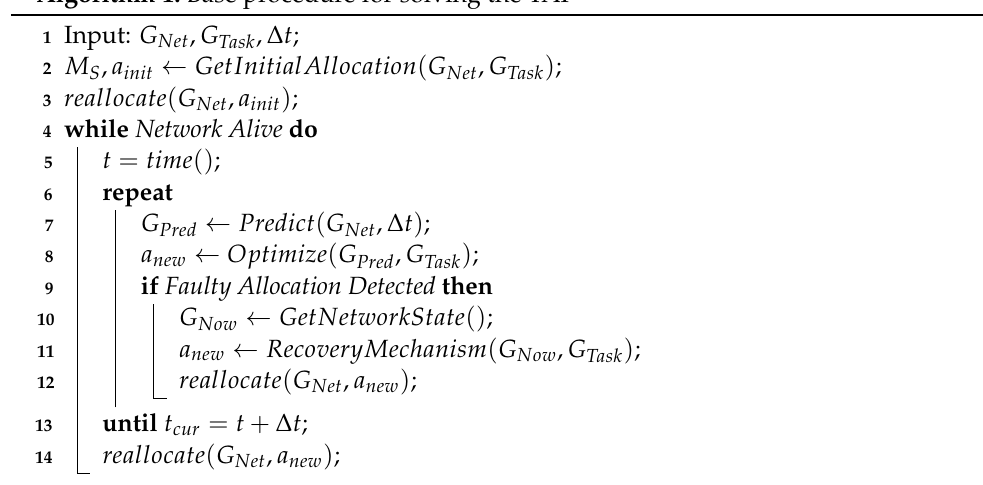
Algorithm 1: Base procedure for solving the